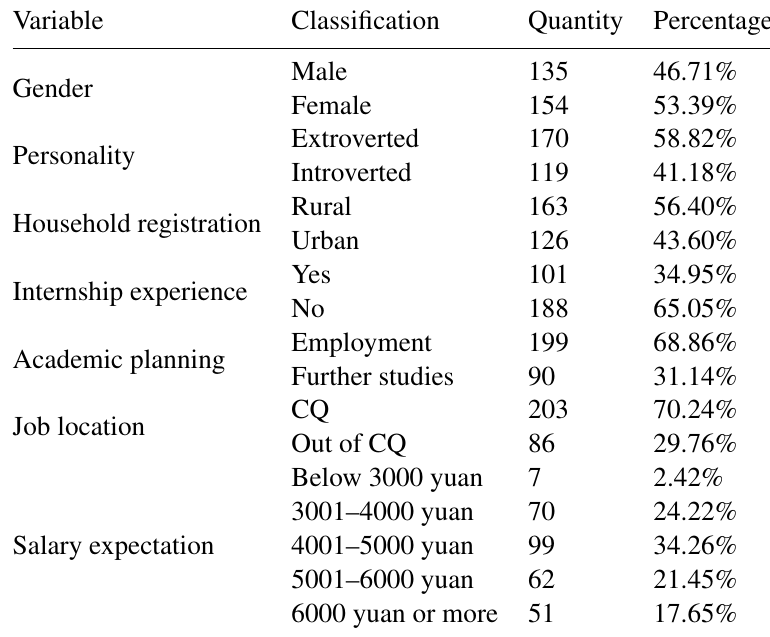
Table 6 Descriptive statistics of individual characteristic